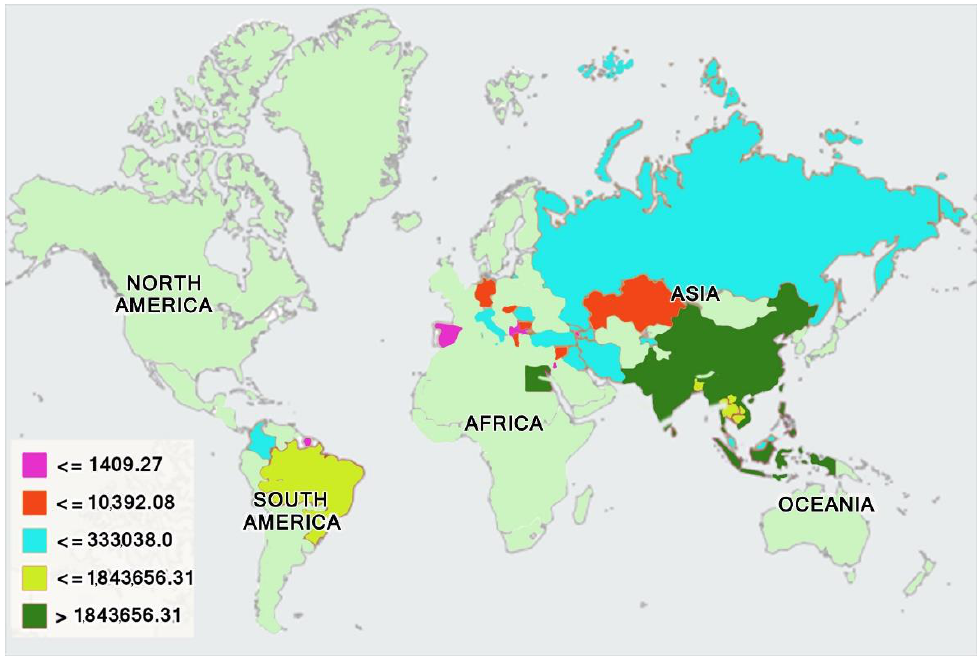
Figure 1. Geographical distribution of buffalo population